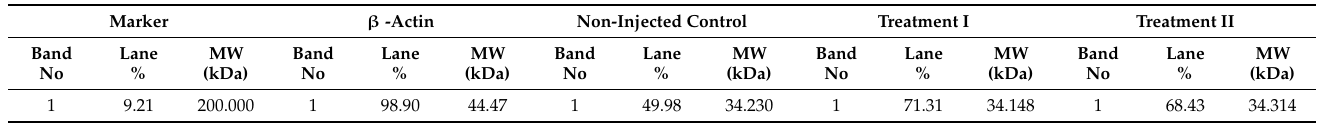
Figure 2 . Molecular weight (MW) calculation of myogenic determination factor 1 (MYOD1) (left) and β -actin (right) proteins expression level for the non-injected control samples and treated groups samples using protein ladder (200 kDa). The calculated MW of MYOD1 34.31 kDa. Table 3. Data parameters of myogenic determination factor 1 (MYOD1) protein expression level for the non-injected control samples and treated groups samples, ( n = 1 from each group) normalized to β -actin (reference protein) referred to lane %, and molecular weight (MW) of MYOD1.